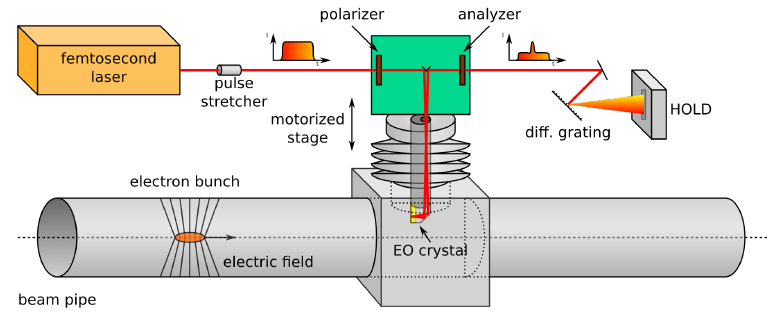
Figure 13. A simplified diagram of EOD setup used at